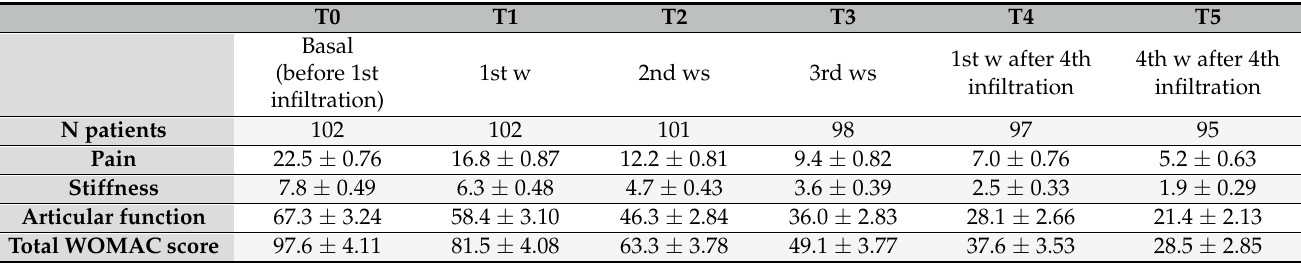
Table 1. Changes in the WOMAC Osteoarthritis Index. Adapted from